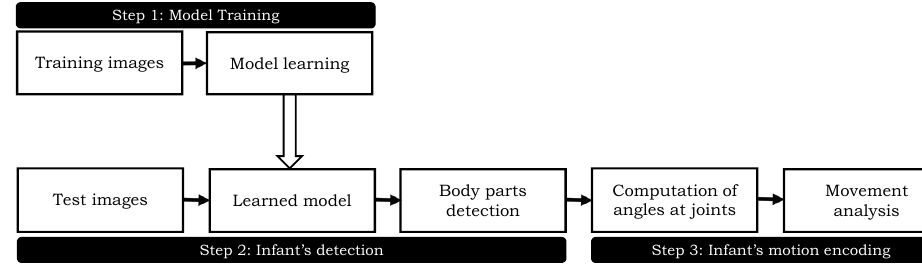
Figure 2. An overview of the proposed method.